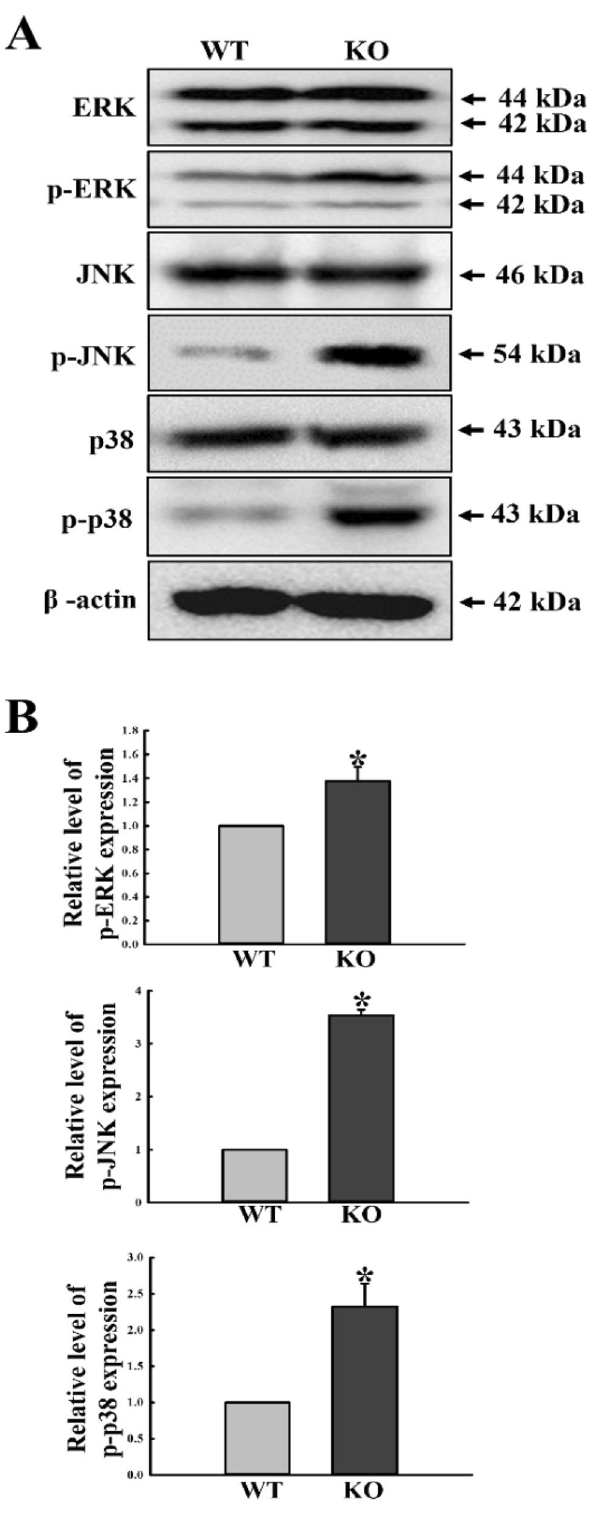
Figure 2. Expression levels of MAPK signaling pathway components. ( A ) Expression levels of ERK, p-ERK, JNK, p-JNK, p38 and p-p38 proteins were determined by Western blot analysis using the specific primary antibody and HRP-labeled anti-rabbit IgG antibody. ( B ) Band intensities were determined using an imaging densitometer, and protein expressions were calculated relative to the intensity of β-actin. Tissue samples were collected from 3 to 5 mice per group, and each lysate was analyzed in duplicate for Western blot (final n = 6–10). Data are reported as the mean ± SD. * indicates p < 0.05 compared to the WT